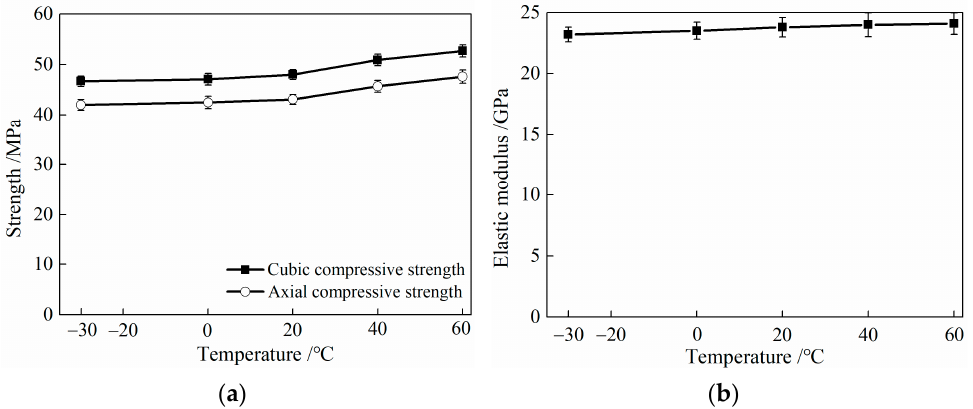
Figure 10. Relationship between feature parameters of compressive property and temperature for HDC. ( a ) Strength. ( b ) Elastic modulus.